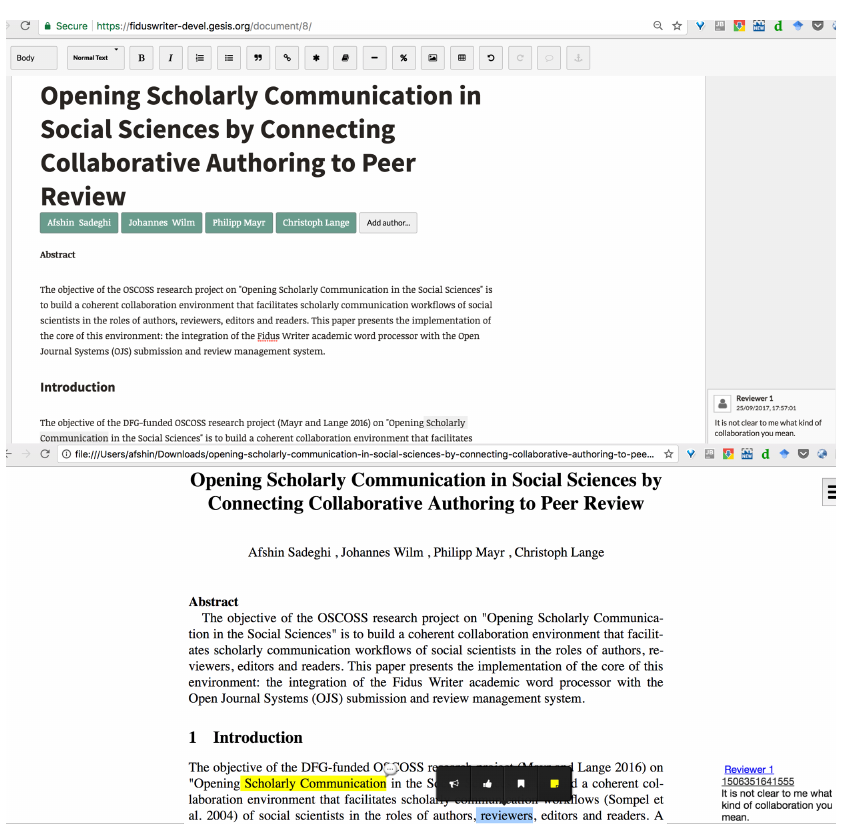
Figure 2. A reviewed article in Fidus Writer ( top ) and dokieli ( bottom